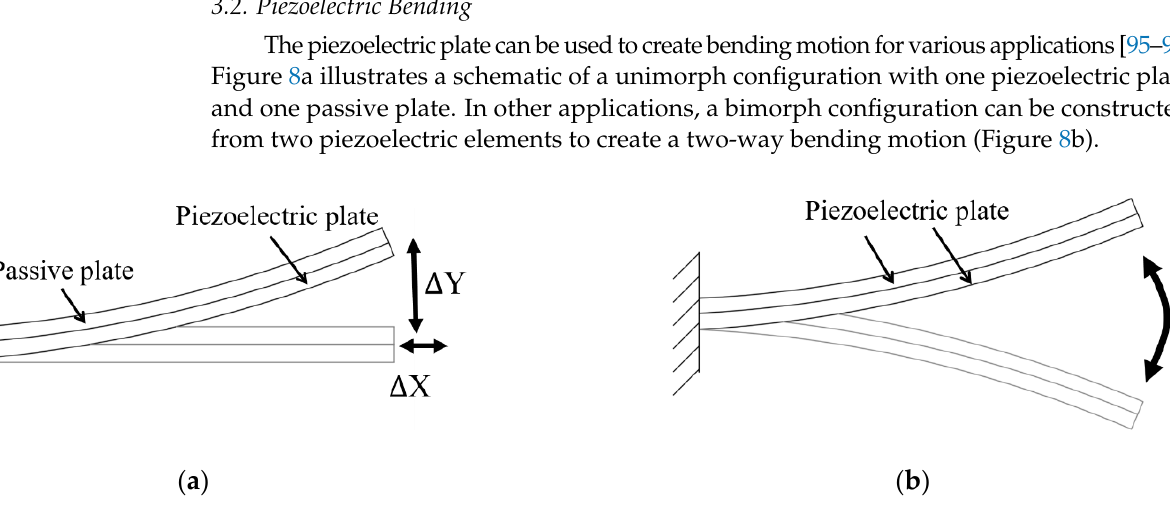
Figure 8. Schematic of ( a ) unimorph configuration and ( b ) bimorph